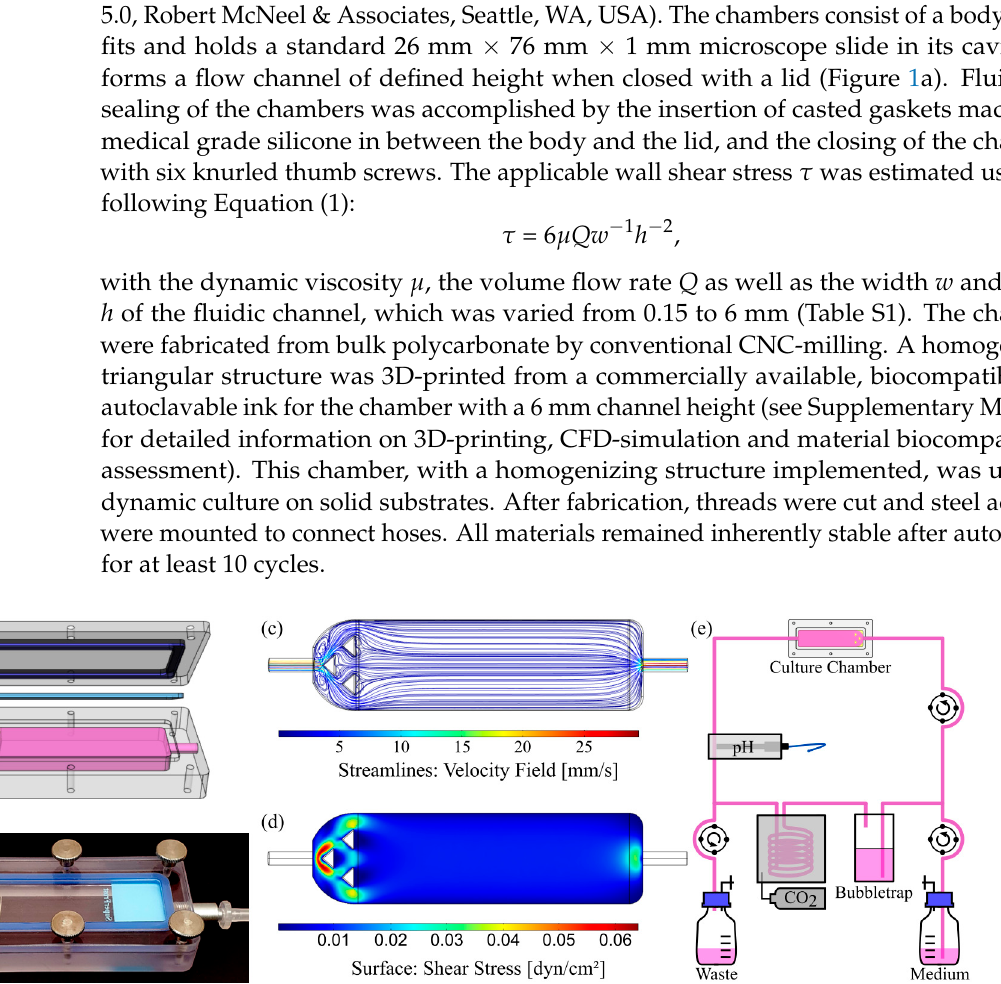
Figure 1. Chamber design, evaluation of flow properties and bioreactor setup for dynamic culture of cells on solid substrates. ( a ) CAD model (exploded view) and ( b ) photograph of the assembled culture chamber with 6 mm channel height and flow homogenizing insert. ( c ) Corresponding velocity streamline profile within the fluid channel and ( d ) surface shear stress obtained by CFD simulation at a volume flow rate of 6.4 mL ∙ min − 1 . ( e ) Schematic illustration of the bioreactor circuit.